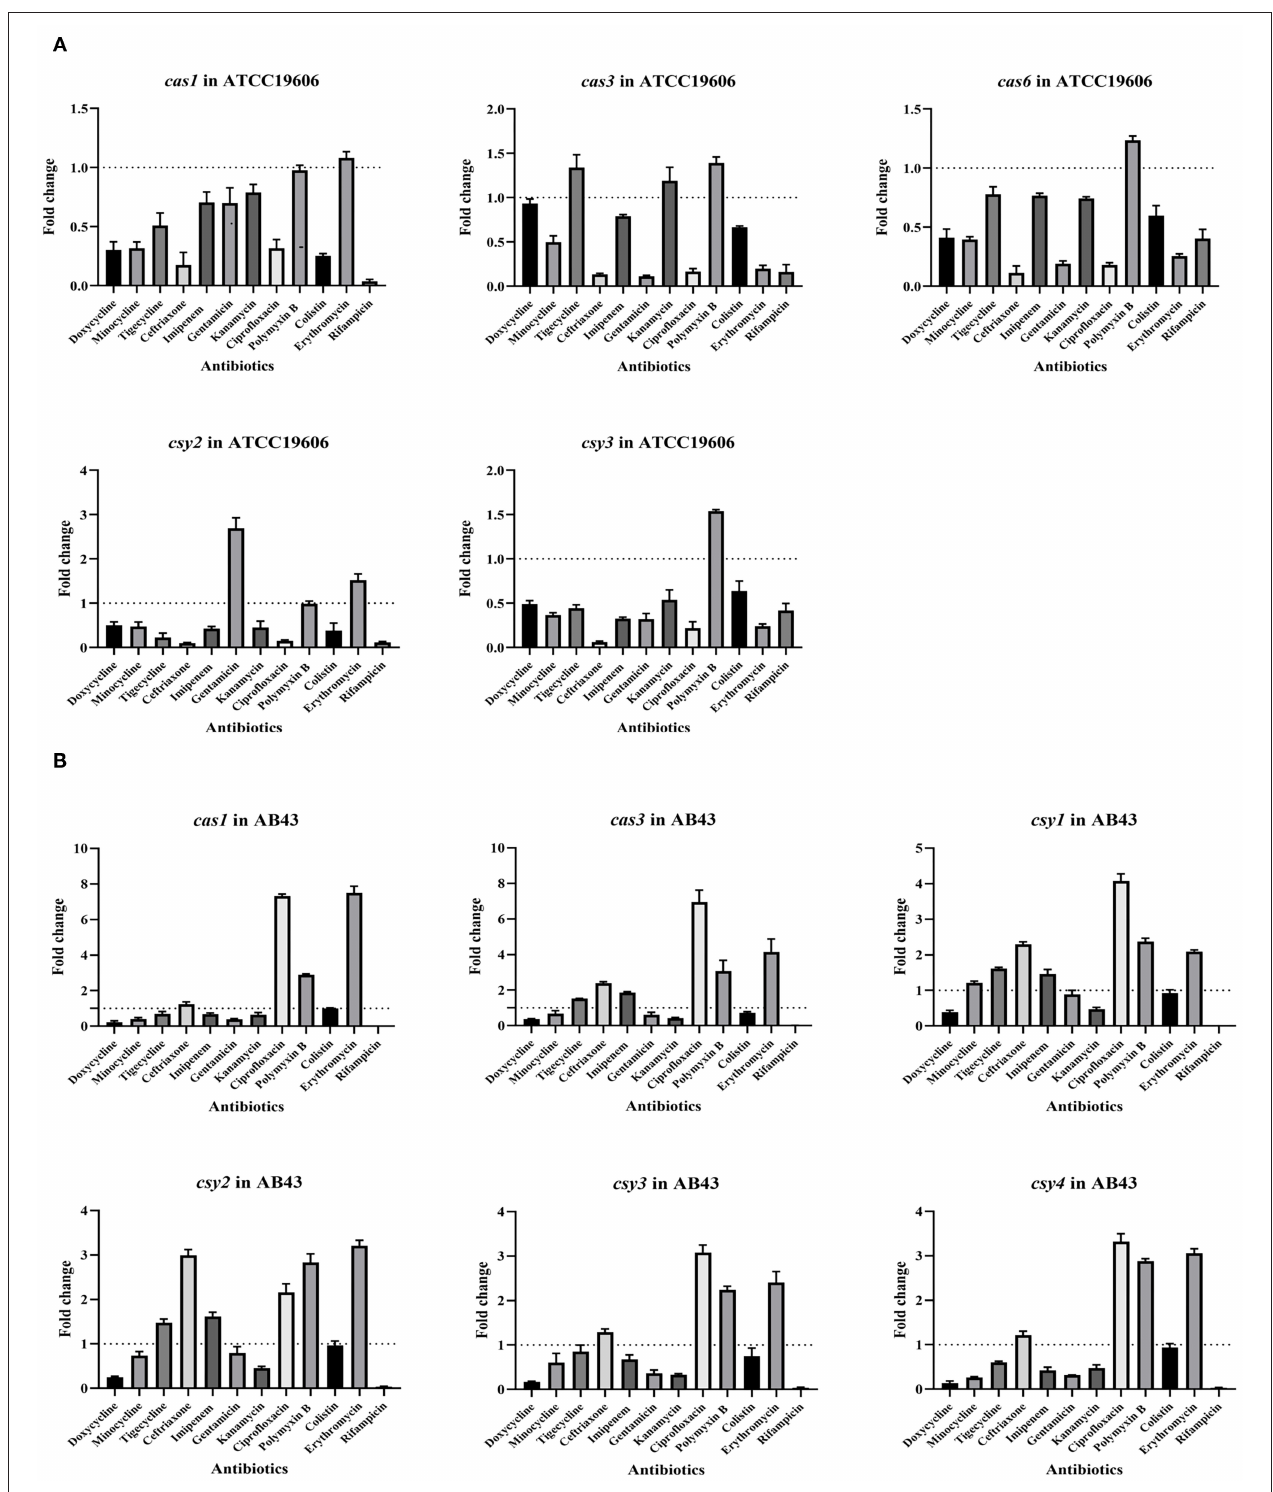
FIGURE 2 | CRISPR-cas gene expression in strains after exposure to antibiotics. (A) CRISPR-related genes ( cas1, cas3, cas6, csy2 , and csy3 ) expression in ATCC19606 against antimicrobials; (B) CRISPR-related genes ( cas1, cas3, csy1, csy2, csy3, and csy4 ) expression against antimicrobials in AB43.